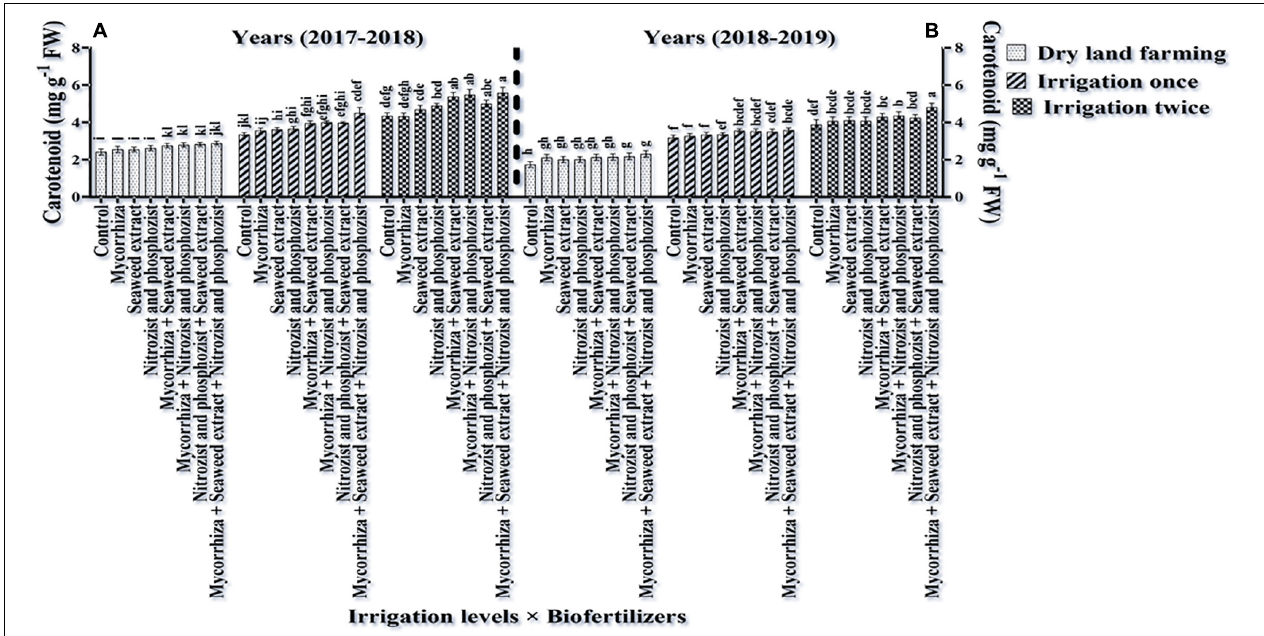
FIGURE 11 | Mean comparisons of the dual interaction effect of irrigation × biofertilizers on carotenoids content of wheat plant in two seasons of experiment (A,B) (2017–2018 and 2018–2019). Means in each column followed by similar letter(s) are not significantly different at 1% probability level by the LSD test.